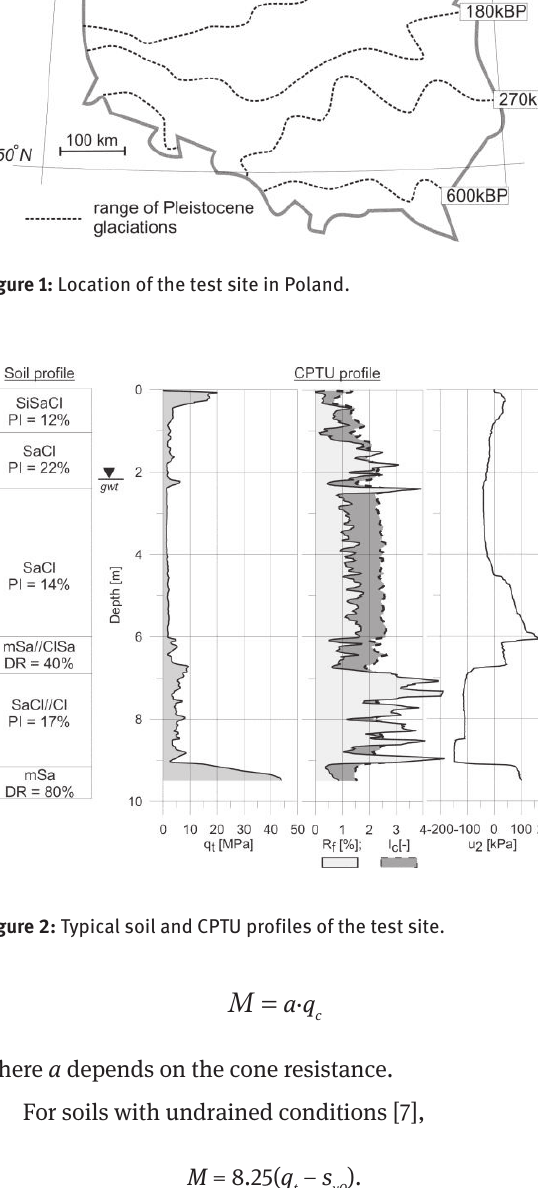
Figure. 3. The division of a subsoil according to the idea of functional data analysis.